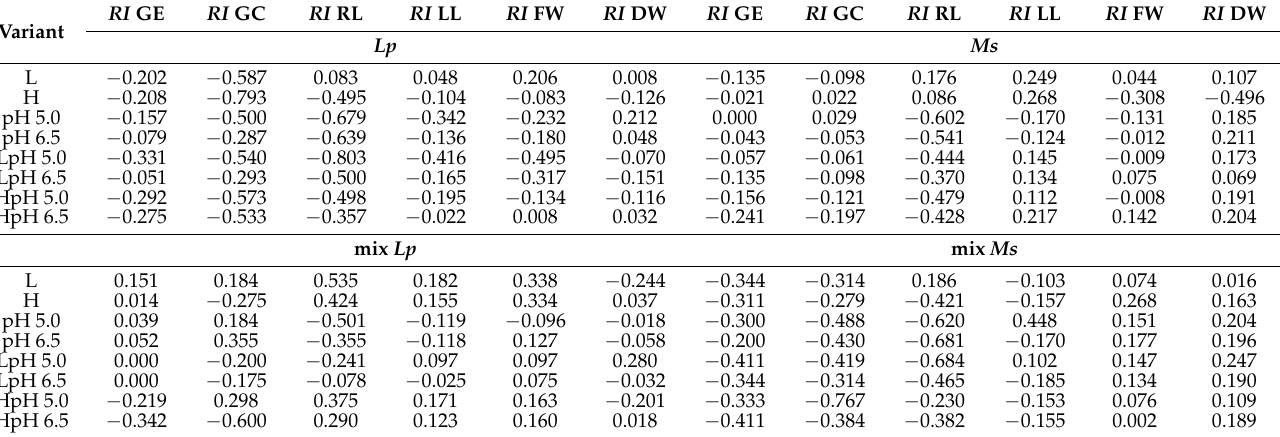
Table 9. Response index ( RI ) of different variants of Medicago sativa root extracts and pH of the solution on the germination and growth of seedlings of L. perenne ( Lp ) and M. sativa ( Ms